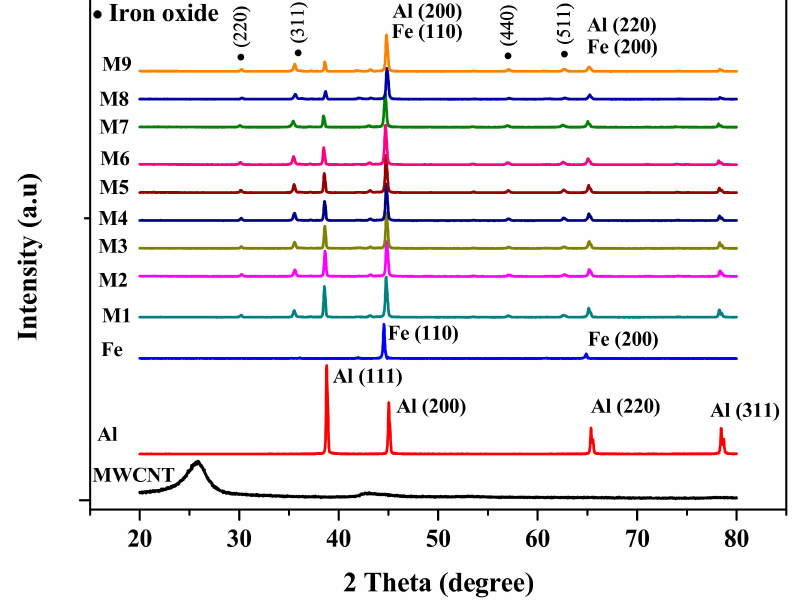
Figure 4. X-ray di ff raction (XRD) patterns of Fe-Al-MWCNT hybrid